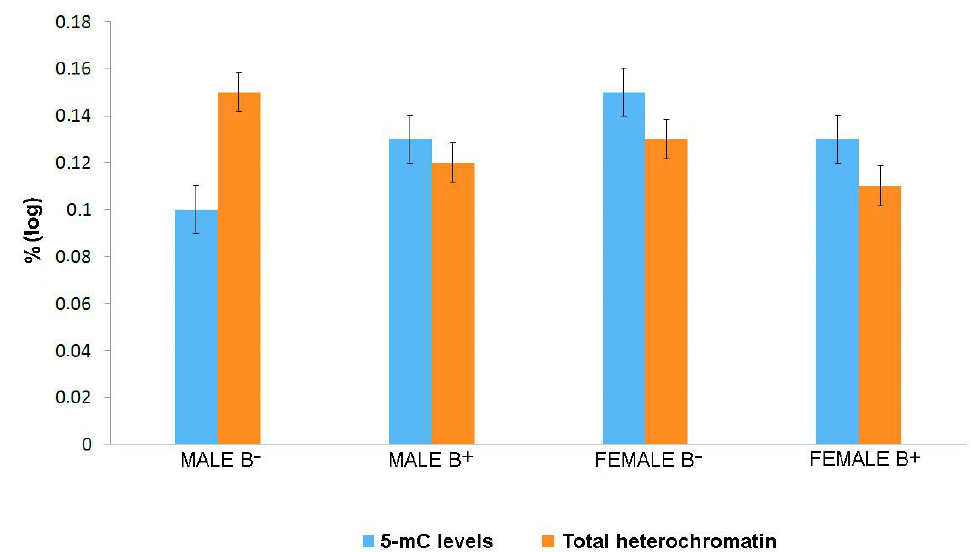
Figure 5. Bar plot showing the methylation conditions of the total genomic DNA ( blue ) and heterochromatin content ( orange ). Genome of male and female without B chromosome is represented by B − and genome with B chromosome by B+. The data were normalized on a logarithmic scale.